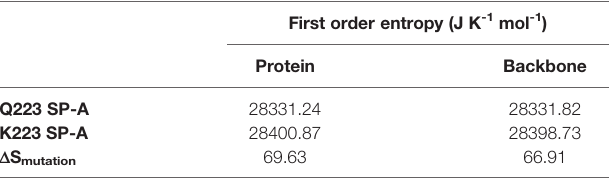
TABLE 3 | First order entropy change ( D S mutation ) in the mutation process for protein and for the backbone chain. First order entropy (J K -1 mol -1